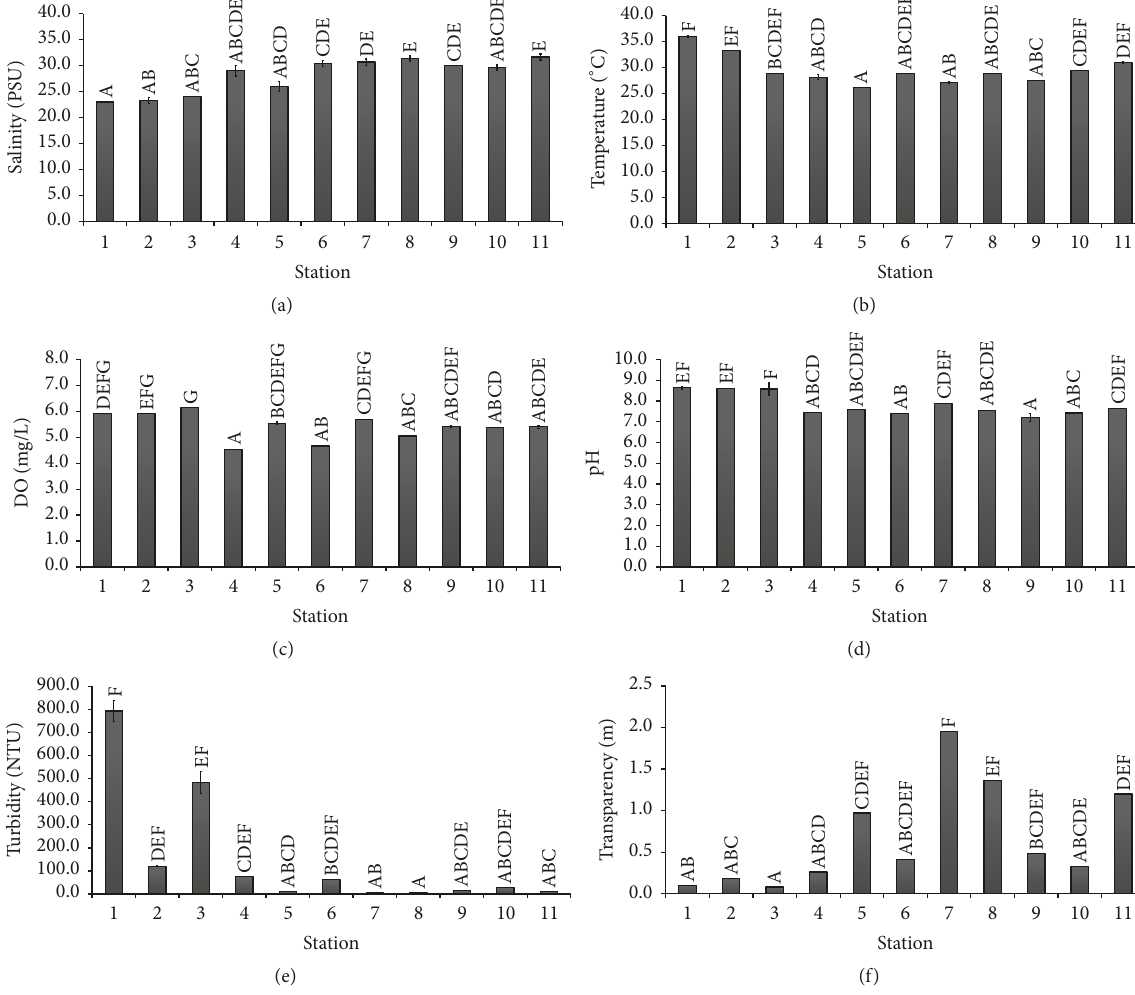
Figure 2: In situ parameters include (a) salinity, (b) temperature, (c) DO, (d) pH, (e) turbidity, and (f) transparency along the coastline of southwestern Sarawak. The same letter indicates no significant difference between the stations at 𝑝 value >